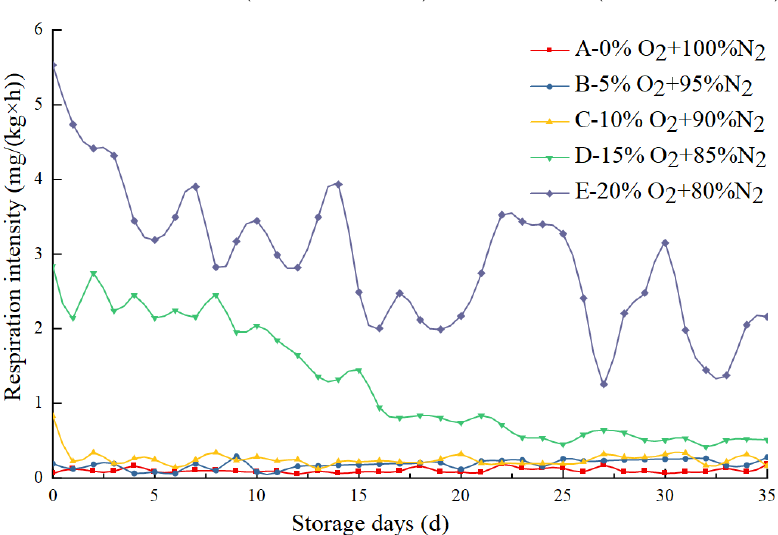
Figure 2. Trend of egg respiration intensity during